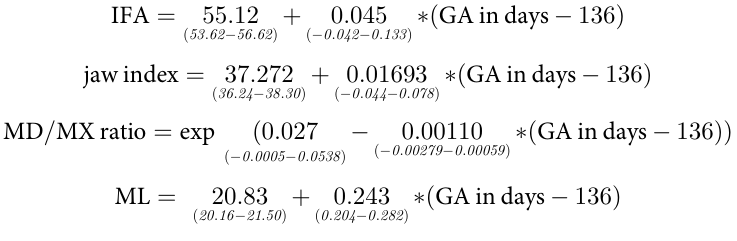
(Each parameter raw data is demonstrated separately in S1 Table).